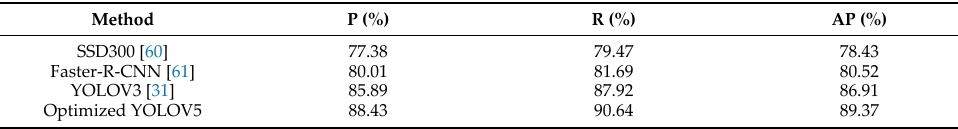
Table 2. Bird detection results on